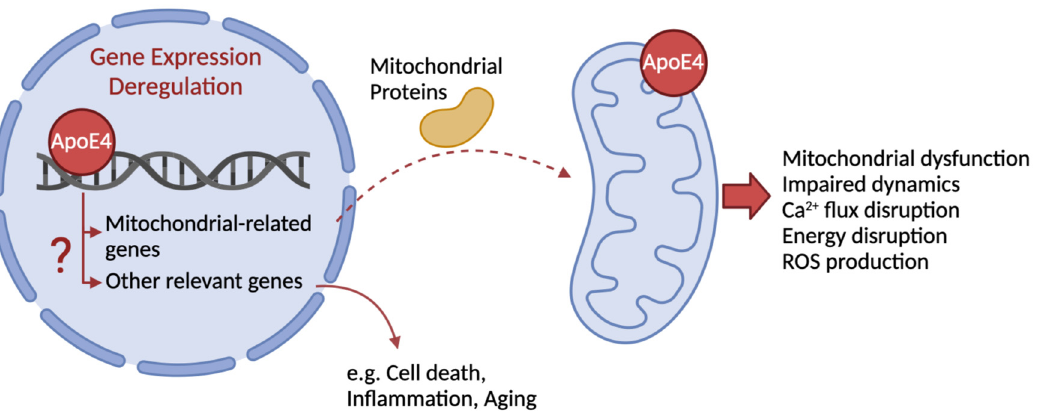
Figure 1. Schematic representation of ApoE4 subcellular localization and potential effects on transcriptional regulation and mitochondrial processes. Previous studies have suggested that ApoE4 acts as a transcription factor, modulating the expression of mitochondrial-related genes and other genes linked to neurodegeneration. ApoE4 may also directly interact with mitochondria, affecting mitochondrial function and dynamics through modified metabolism and fusion/fission imbalance, respectively.